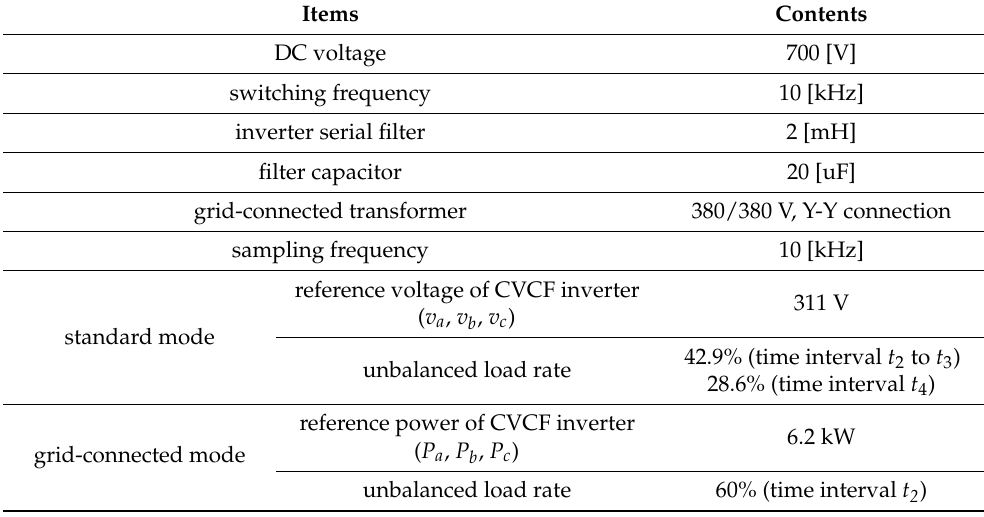
Table 1. System parameter.